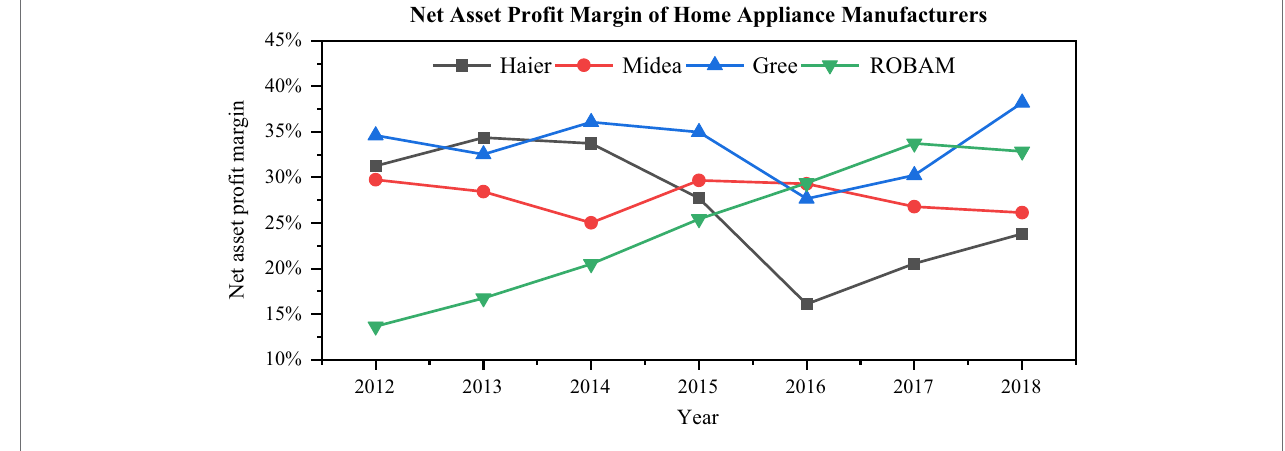
FIGURE 1 | Comparison of profitability between Haier and similar companies.